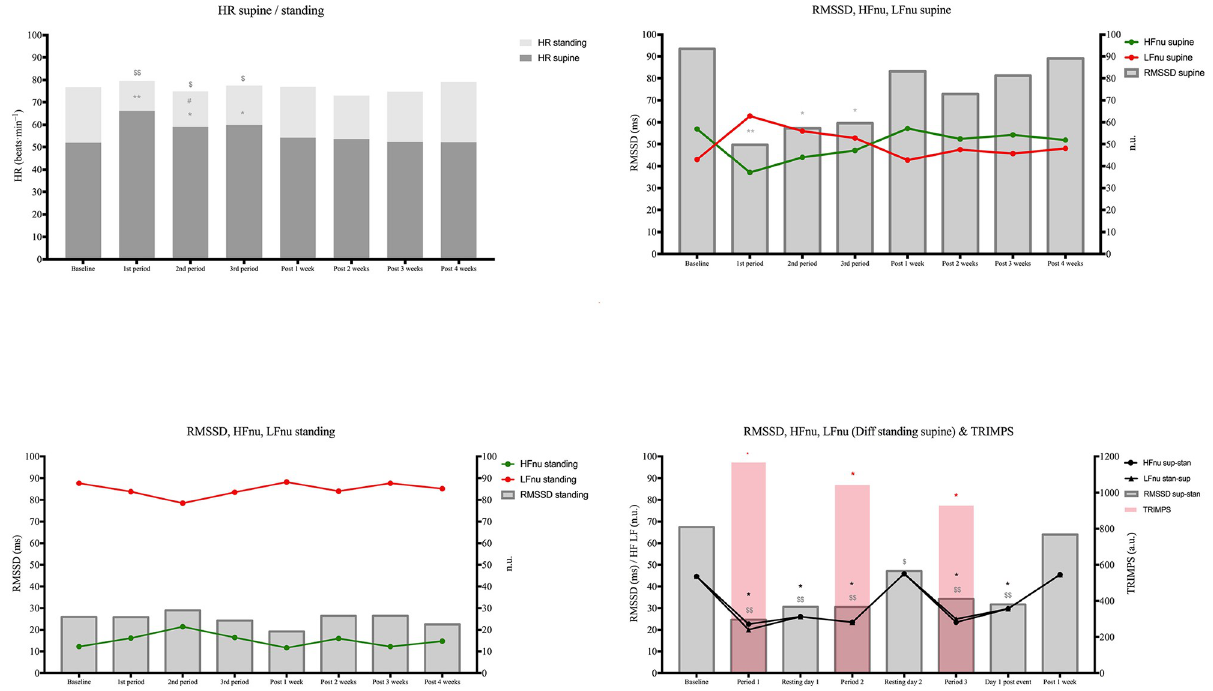
Fig 2. Evolution of heart rate and HRV parameters by period. Data are presented as mean group values for each period. Period 1: from stage 1 until stage 9 inclusive, period 2 from stage 10 until stage 15 inclusive, period 3 from stage 16 until stage 21 inclusive. Post: post-Tour period. Statistical differences: Different from baseline � ( P < 0.05); different from the previous period # ( P < 0.05). Standing-supine values different from baseline $ ( P < 0.05); different from previous period £ ( P < 0.05). HR: heart rate; RMSSD: root mean square of the successive differences; HF: high frequency; LF: low frequency; ms: milliseconds; n.u.: normalized units; TRIMPS: training impulse.